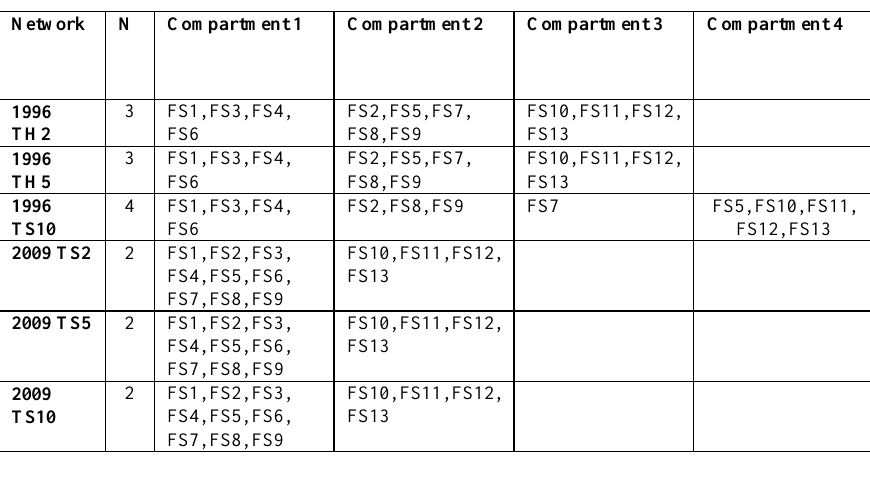
Table A5. Motif sensitivity